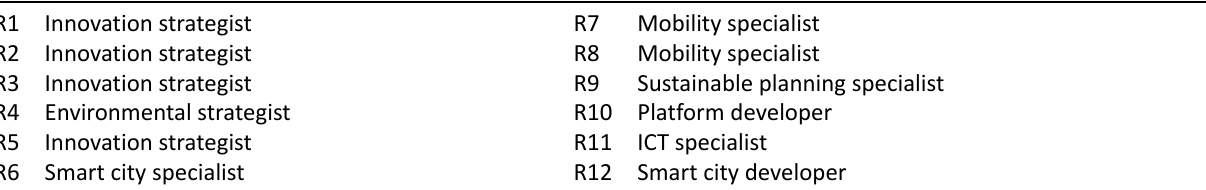
Table 2. List of Stockholm